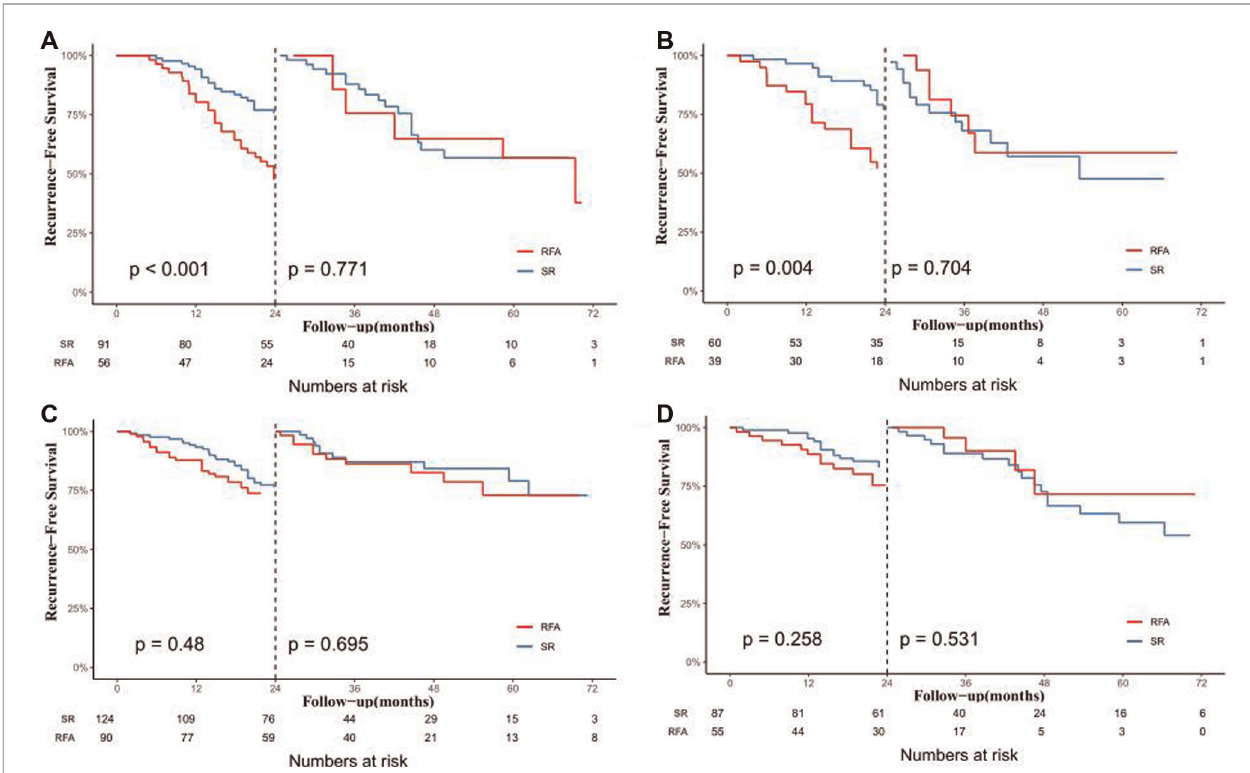
FIGURE 4 | Analysis of the effect of different treatments on early and late postoperative recurrence in HCC patients by landmark method. In the training cohort ( A ) and validation cohort ( B ) of CTC-positive patients; In the training cohort ( C ) and validation cohort ( D ) of CTC-negative